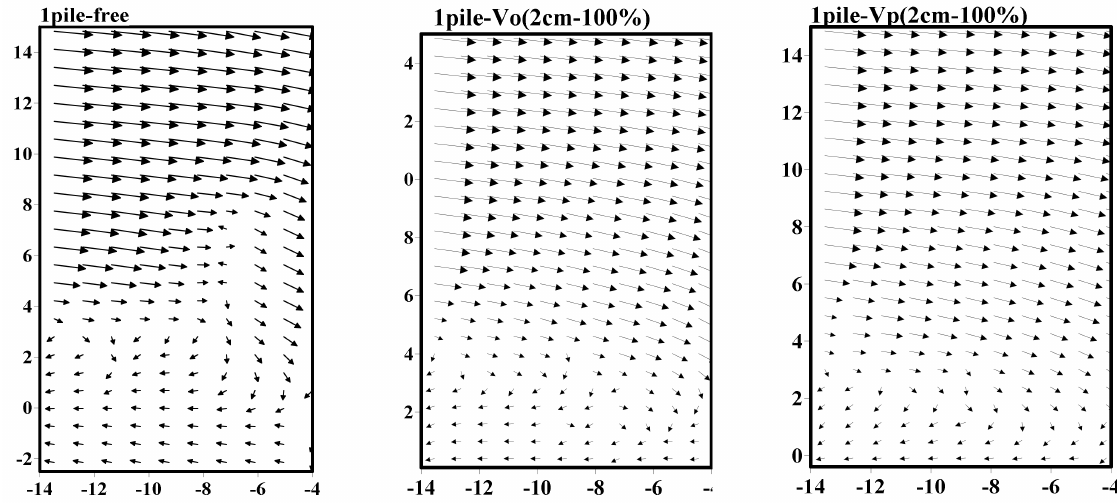
Figure 10. The X–Z resultant velocity vector on the center axis of the channel upstream of the first pile in a single pile